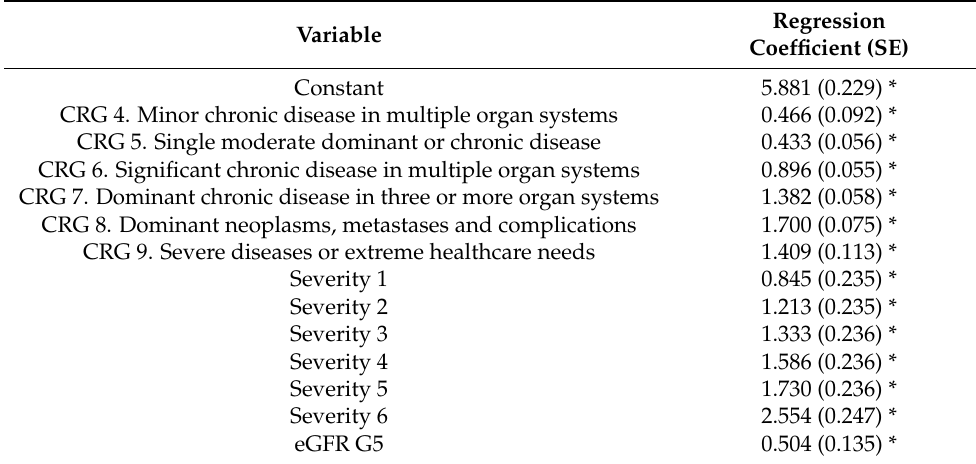
Table 5. Multiple linear regression of cost